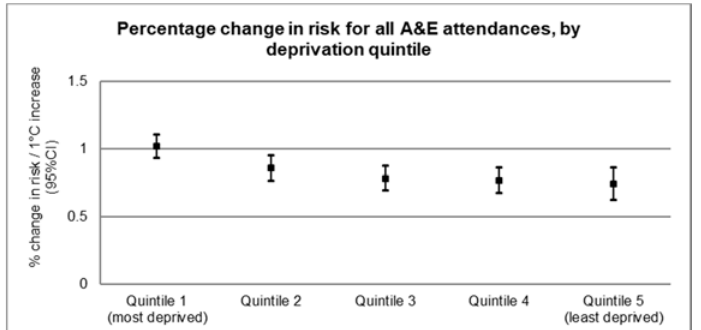
Figure 4. Effect modification by deprivation quintile for all ‐ cause A&E department attendances in Figure 4. E ff ect modification by deprivation quintile for all-cause A&E department attendances in Greater London between 2007 and 2012. Greater London between 2007 and